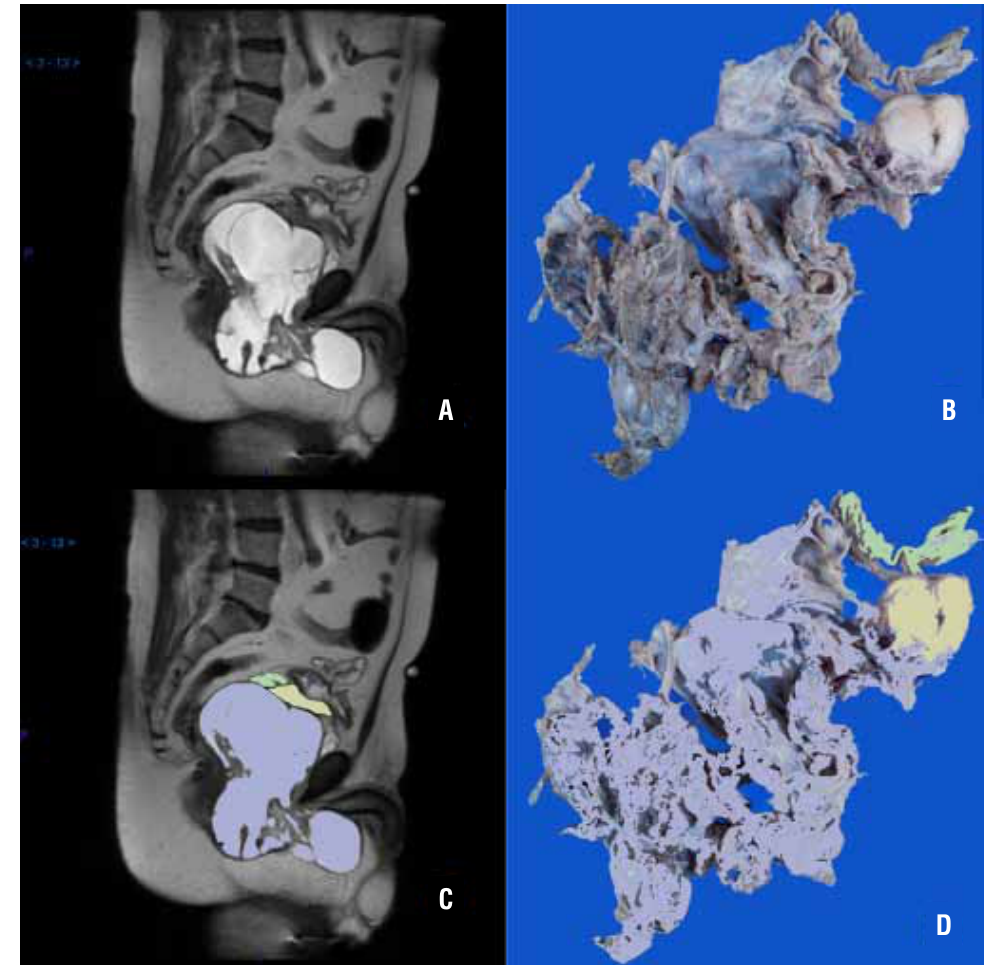
Figure 1 - (A) MRI T2 sagittal view (B) Macroscopic pathological specimen (C and D) MRI and macroscopic pathological specimen in colors. Prostate, seminal vesicles and the tumor are depicted in yellow, green and purple